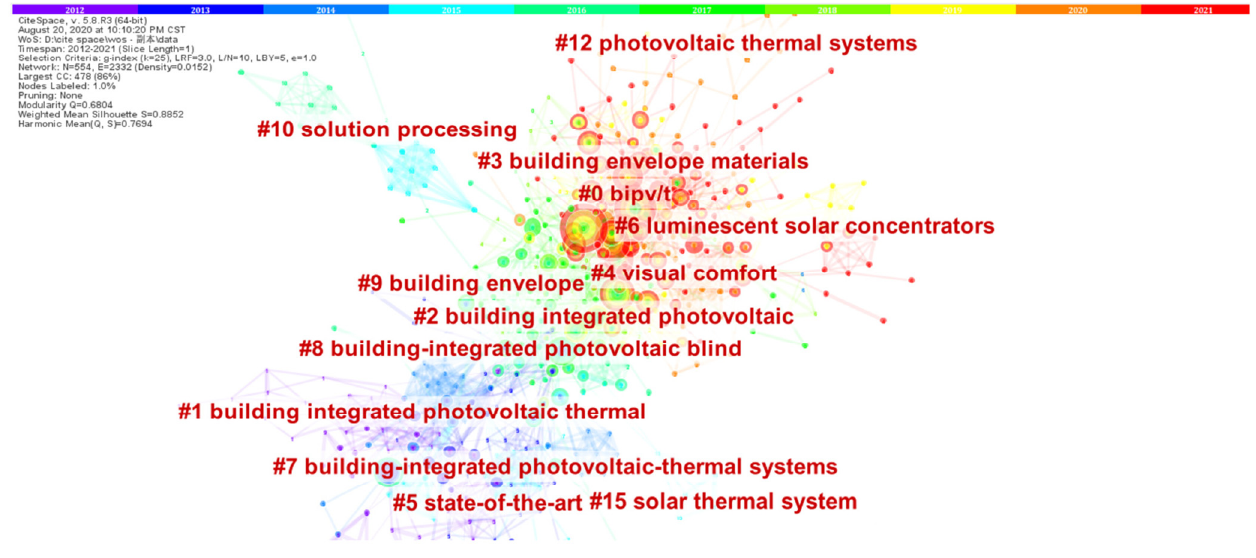
Figure 9. Literature co ‐ citation cluster. Table 12. Literature cluster labels.